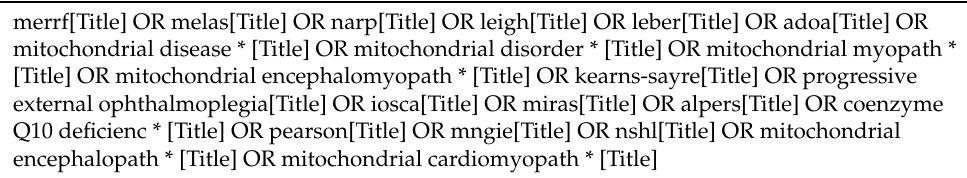
Table 1. Pubmed search. The parameters of our search on Pubmed are reported here. Note that the symbol * is the Pubmed wildcard for every possible word beginning or